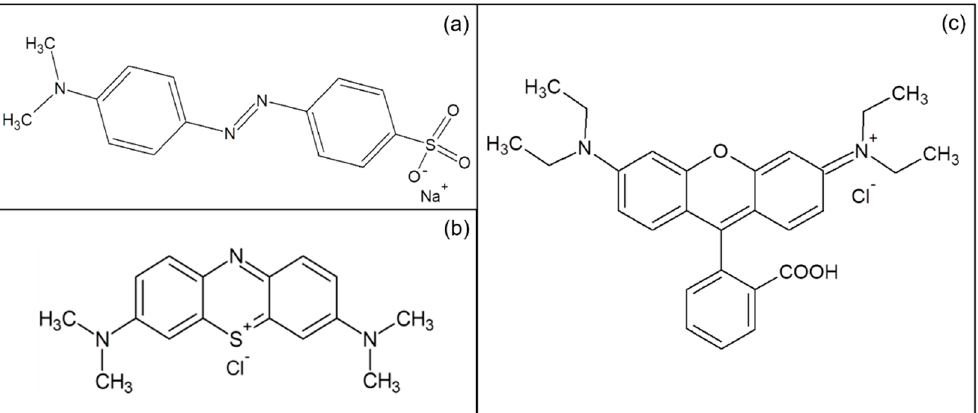
Figure 5. Molecular structure of ( a ) MO, ( b ) MB, and ( c ) RHB.